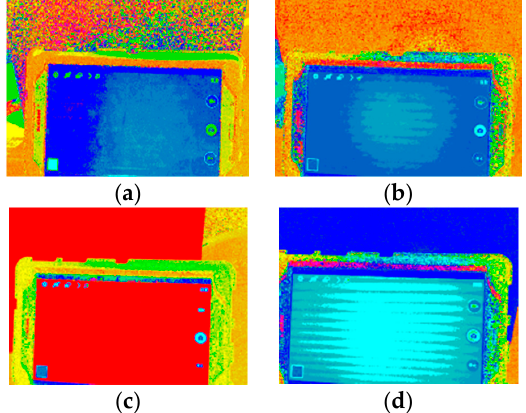
Figure 5. Comparison images of the corresponding colors shown on the high definition LED display monitor. The LED compared images for ( a ) black; ( b ) white; ( c ) red; and ( d ) blue.